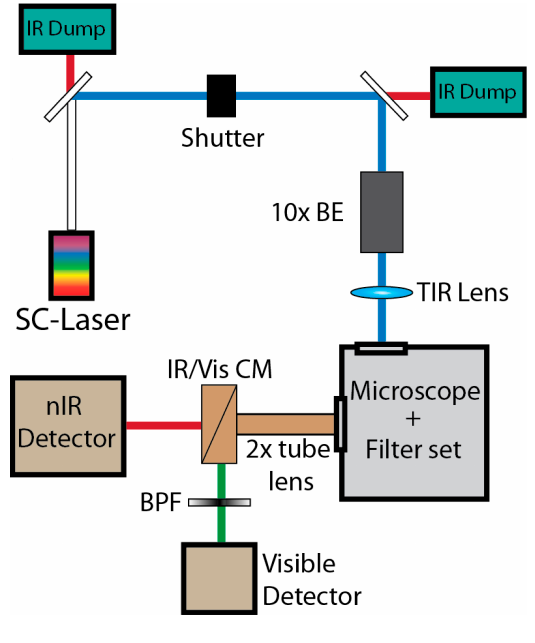
Figure 1. Instrument design. A Supercontinuum (SC) laser is attenuated with a neutral density (ND) filter. The beam undergoes 10× beam expansion (BE) to overfill the microscope objective for beam-steering via a plano-convex lens. A collimating lens in the microscope body collects emission while a 2× tube lens expands the image to fill the imaging plane of two detectors. A cold mirror (CM) separates nIR and visible light. Visible path: Signal is filtered with a band-pass filter (BPF) onto an EM-CCD camera in a 512 × 512 pixel imaging area. nIR path : nIR emission is directed onto a nIR detector at the same imaging plane as the visible detector (with permission from